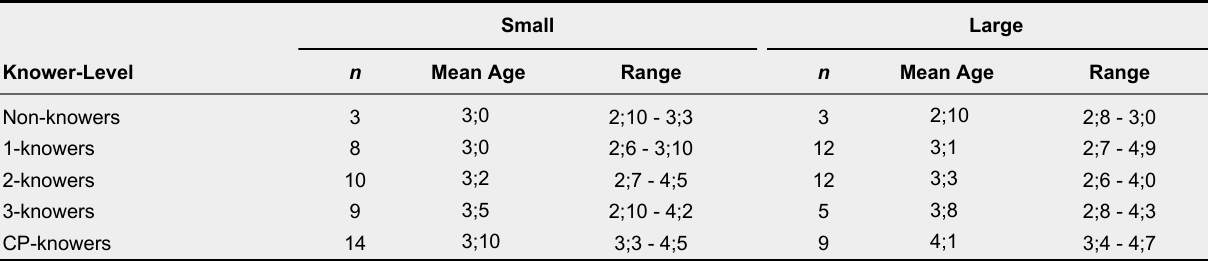
Age and Number of Children in Each Knower-Level Group in Experiment